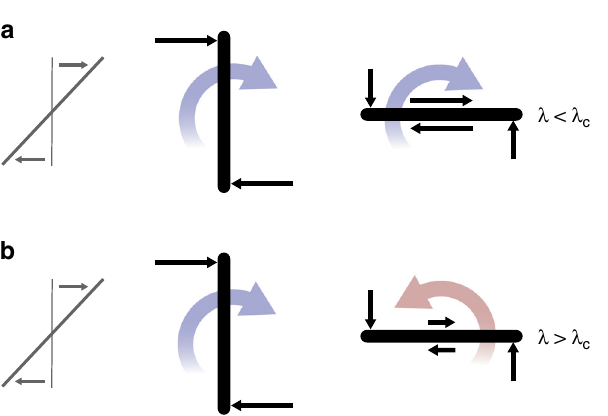
Fig. 5 Dominant contributions to the torque. Schematic of the dominant contributions to the torque applied on the platelet under shear fl ow for small slip length ( a ) and large slip length ( b ). The coloured arrows indicate the direction